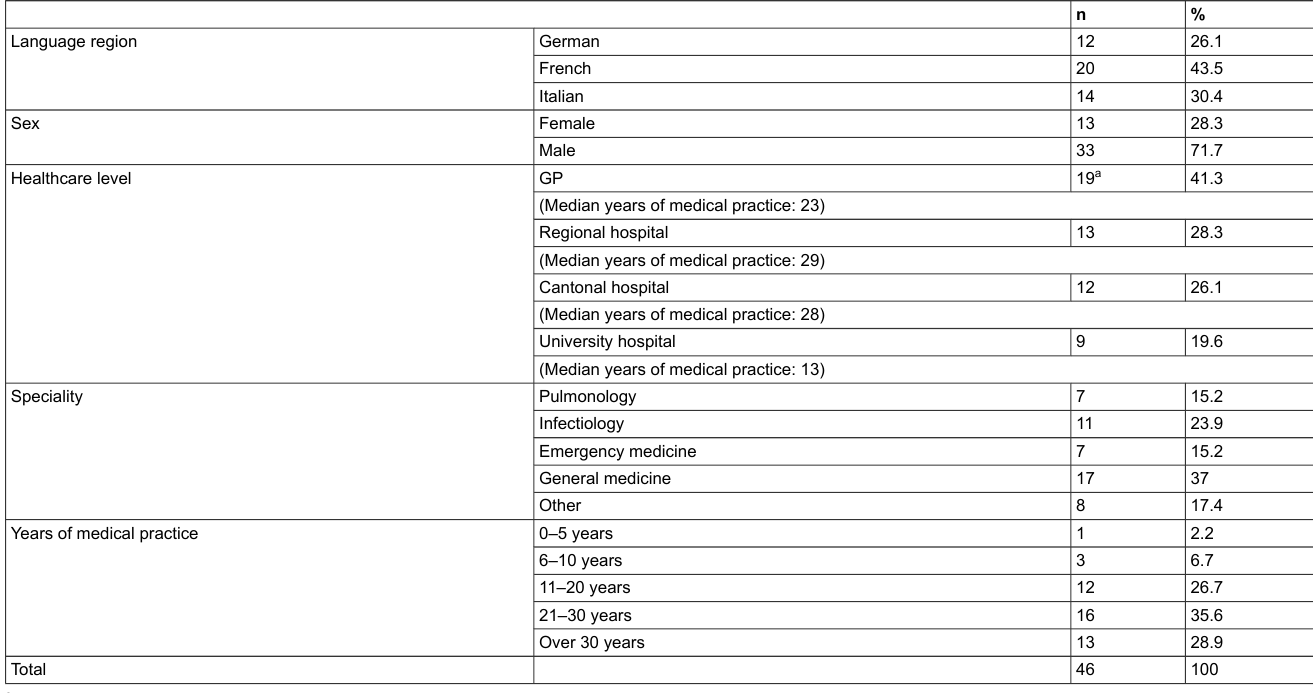
Table 2: Characteristics of physicians included in the study on pneumonia and Legionnaires' disease case management in